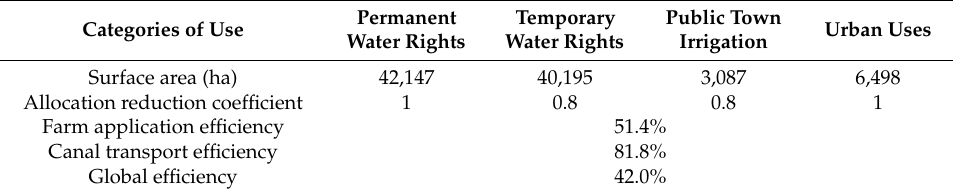
Table 2. Water rights to irrigation water use and efficiencies. Mendoza River